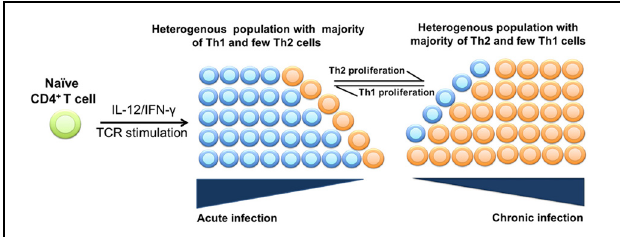
FIGURE 2 | Population plasticity of effector CD4 + T cells in chronic infections. During an acute phase of infection, naïve CD4 + T cells differentiate into a heterogeneous population consisting mainly of Th1 cells and a few Th2 cells. However, as the disease progresses into a chronic phase, there is a gradual loss of Th1 cells and accumulation of Th2 cells. Accumulation of Th2 cells may occur due to a higher proliferation rate/reduced death rate of Th2 cells than that of Th1